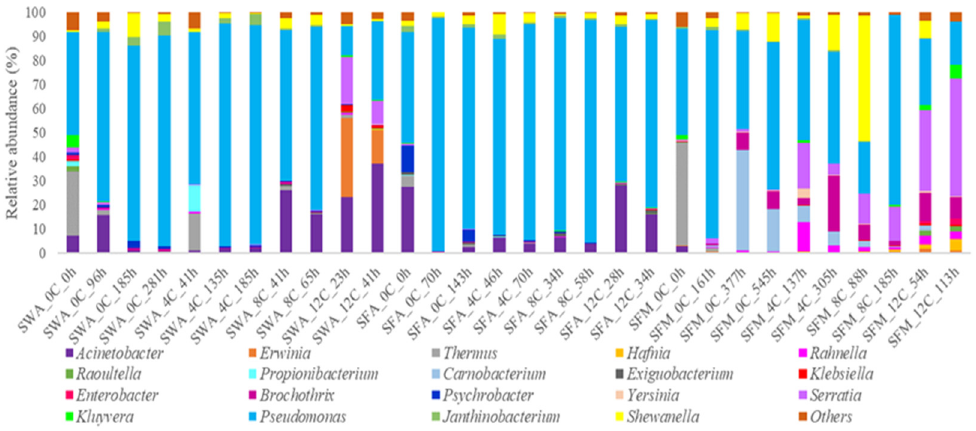
Figure 2. Relative abundance (%) of bacterial genera of whole (SW) and filleted sea bass (SF) at intervals of storage hours (h), at various temperatures (C) under air (A) and MAP (M) conditions, as revealed by 16S rRNA metabarcoding analysis.